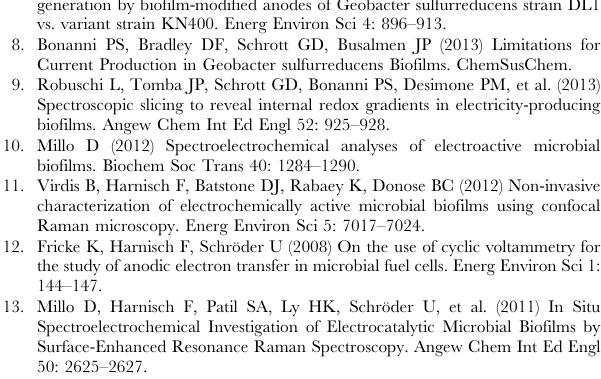
Table S1 Band assignment of prominent bands in the RR spectra of mixed-culture electroactive biofilms. Normal mode assignment and allocation of local coordinates of the most prominent bands from the averaged Raman spectra obtained with the working electron poised at 0 or 2 0.6 V. (PDF) Figure S1 Turnover CVs of electroactive biofilms recorded at different developing stages. Turnover CVs recorded in the presence of 10 mM sodium acetate as metabolic substrate, A) at day 10, B) at day 57, C) at day 80. (TIF) Figure S2 Profiles of current (red trace) and electrode potential (blue trace) recorded prior the collection of RR spectra from biofilms. A) Nonturnover at 0 V (RR spectra reported in Figure 3C and D.) B) Nonturnover at 2 0.6 V (RR spectra reported in Figure 3G and H). C) Turnover at 0 V (RR spectra reported in Figure 5C and D). (TIF) Figure S3 Schematic representation of the electrochem- ical cell used for confocal resonance Raman microscope observations. A) Side view, and B) top view. WE: working electrode (glassy carbon). CE: counter electrode (Pt wire). RE: reference electrode (Ag/AgCl in 3 M KCl).